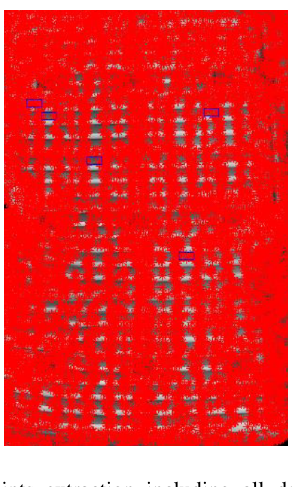
Figure 10. Points extraction including all detected Förstner points.